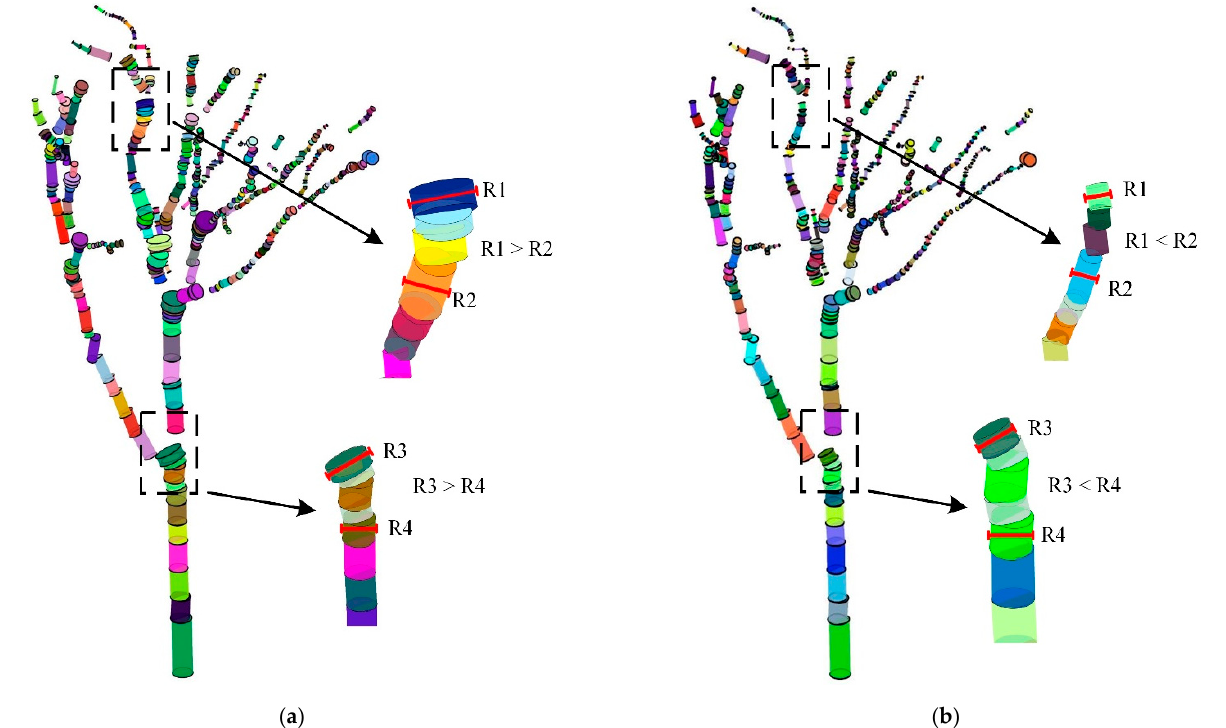
Figure 10. Branch model comparison before and after local optimization. ( a ) Branch model before optimization; ( b ) branch model after optimization. R1, R2, R3, and R4 are the diameters of the fitted cylinders.